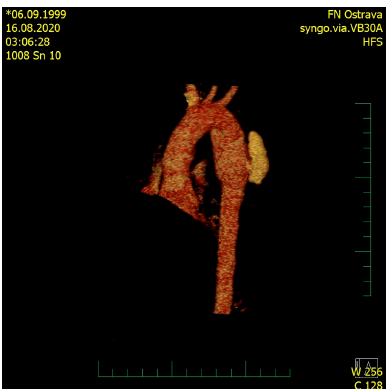
Figure 1. CT 3D reconstruction of the aortic arch with the leak of the contrast agent.